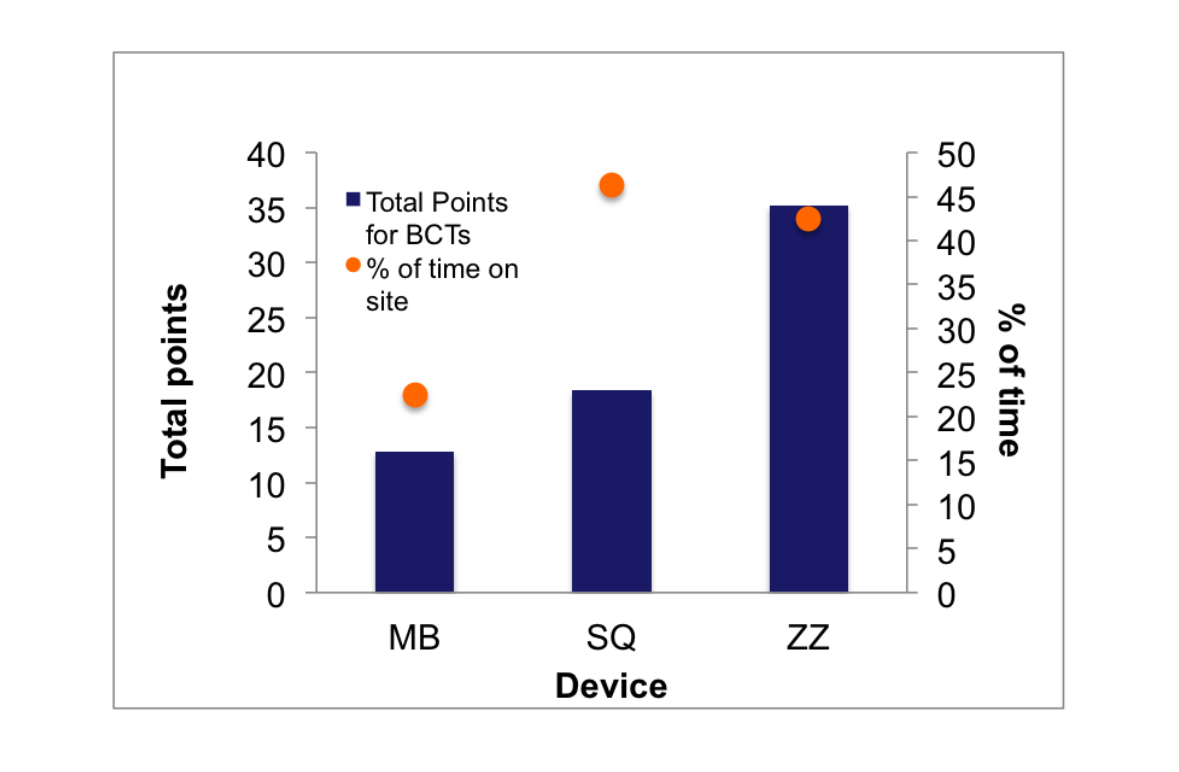
Figure 3. Summary data from behavioral change technique (BCT) scores adjusted for location on the device or website (points) and cognitive interviews (% of time on each site). MB: Movband; SQ: Sqord; ZZ: